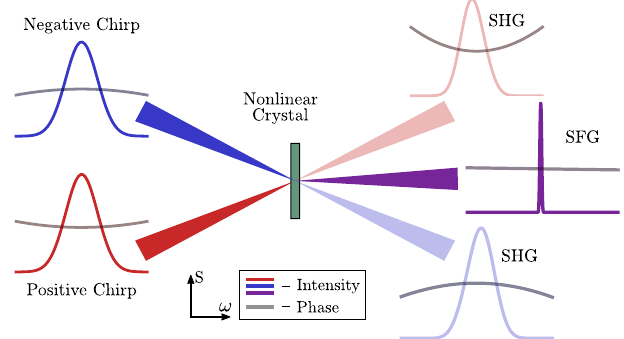
FIG. 1. DCNS method in the spectral domain demonstrating two pulses of equal on opposite chirp mixing in a nonlinear medium to generate chirped second harmonic (SHG) copies of each pulse along with the narrow band, flat phase, sum frequency (SFG)